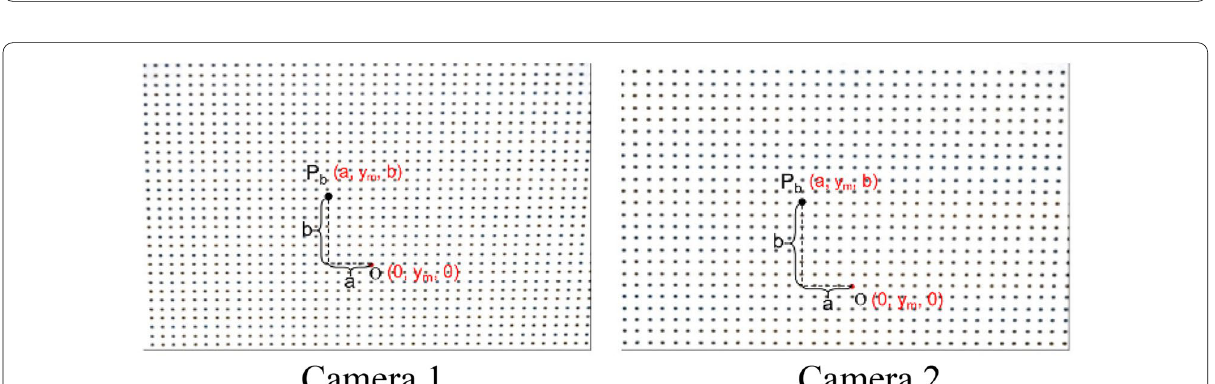
Figure 2 The 3D point array